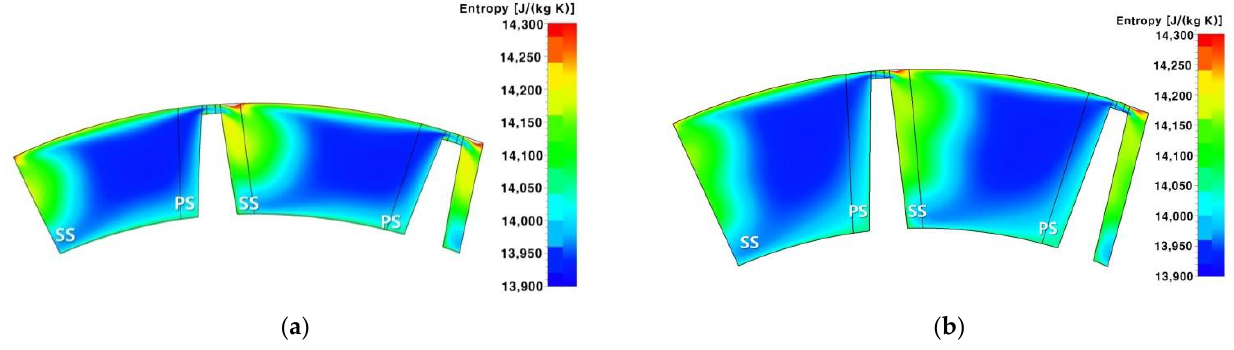
Figure 15. Comparison of entropy distribution at mid-span of the rotor (Plane 1): ( a ) original mod- el and ( b ) optimized model.